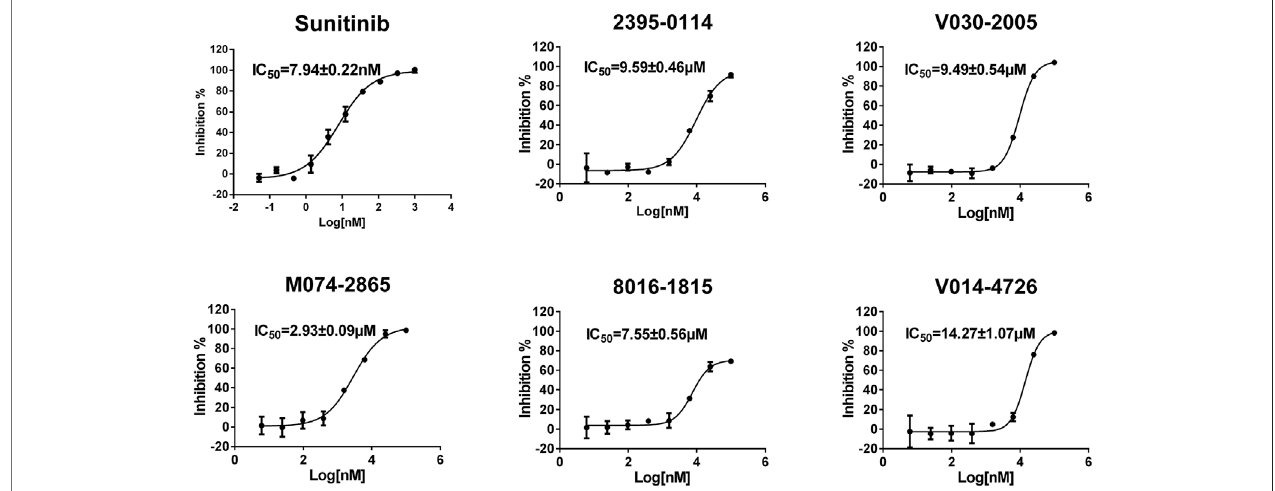
FIGURE 3 | Inhibitory activity curves of sunitinib (positive control compound) and the fi ve active compounds against HPK1 kinase.